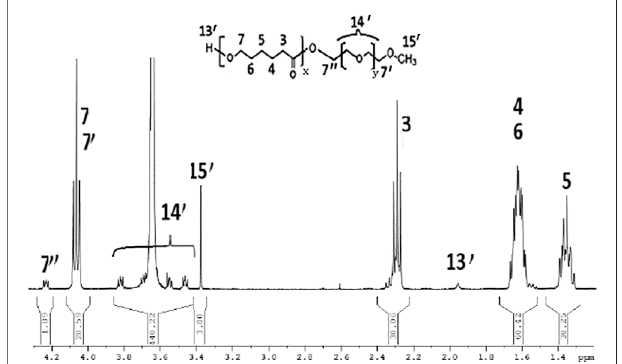
FIGURE 5 | 1 H NMR spectrum of the model compound mPEG- b